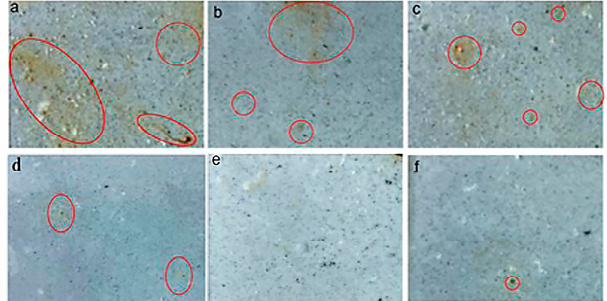
Figure 9. Surface morphologies of the coatings after the salt spray test for 600 h: ( a ) neat EP; ( b ) GO (0.7 wt.%) / EP; ( c ) STG (0.2 wt.%) / EP; ( d ) STG (0.5 wt.%) / EP; ( e ) STG (0.7 wt.%) / EP; and ( f ) STG (1.0 wt.%) / EP.